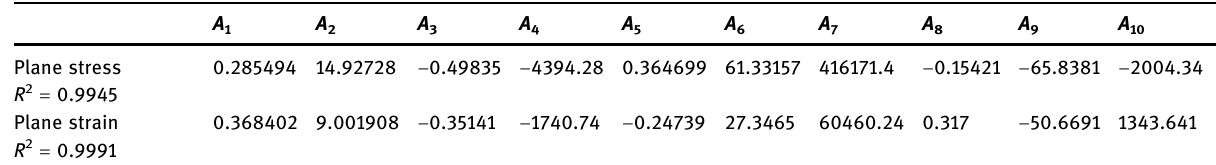
Table 1: Coe ffi cients of fi tting equation ( 7 ) to the obtained numerical results [ 15 ]